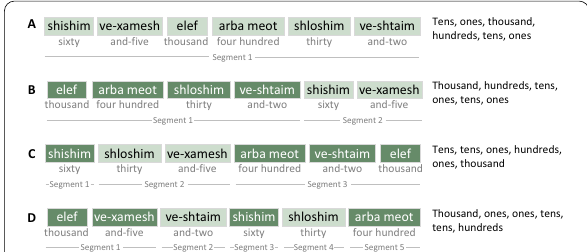
Fig. 1 Experiment 1 design. The participants heard sequences of number words in Hebrew, and repeated each sequence. Each of the 4 conditions included 20 stimuli (sequences), derived from the same 20 numbers (in this example: 65,432). The stimulus words were shuffled in a different manner in each condition, according to that condition’s fixed word order (shown here on the right). Thus, the number and length of grammatical segments was fixed for each condition, and different between conditions. A stimulus included either 6 words (as in this example) or 7 words, depending on the participant’s short-term memory capacity. For the 7-word stimuli, the word order in each condition was A [hundreds, tens, ones, thousand, hundreds, tens, ones]; B [thousand, hundreds, tens, ones], [hundreds, tens, ones]; C [hundreds, tens], [hundreds, ones], [tens, ones, thousand]; D [thousand, ones], [ones], [tens], [tens], [hundreds],